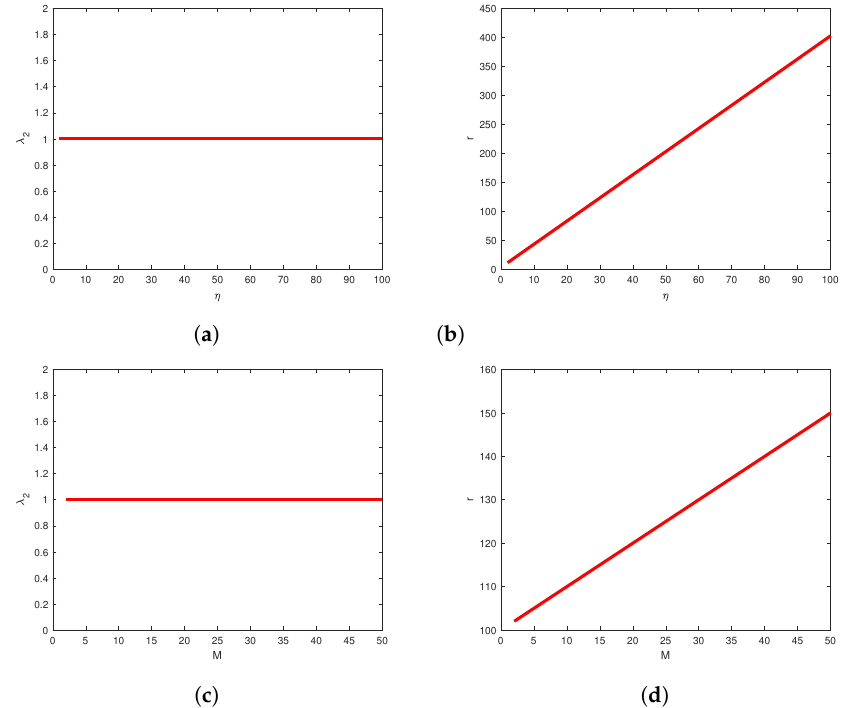
Figure 5. The synchronizability of Networks-A. Panel ( a ) depicts λ 2 vs. η and ( b ) depicts r vs. η when a = 2, d = 1, M = 2; Panel ( c ) depicts λ 2 vs. M and ( d ) depicts r vs M when a = 1, d = 1, η =